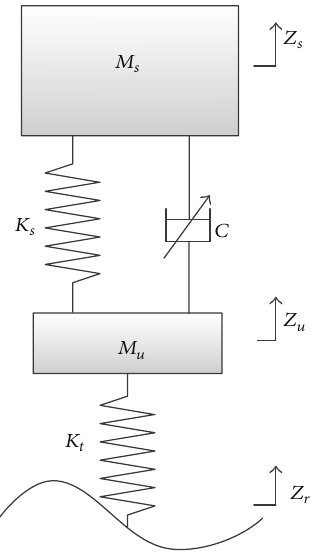
Figure 1: Quarter-vehicle model with semiactive suspension sys-